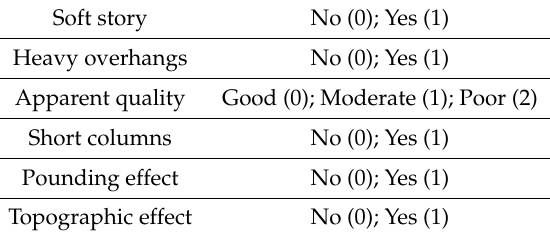
Table 6. Vulnerability parameters in EMPI